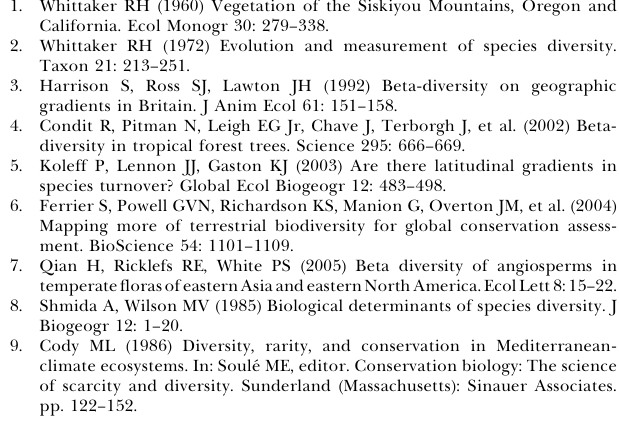
Figure S1. Scatter Plots Showing Relationships between Beta- Diversity and Two Environmental Variables (Elevation and Number of Biome Edges within Grid Cells) For each panel, untransformed (left plots) and transformed (right plots) values of b sim-d ( y -axis) against either grid cell elevation ( x -axis, upper plots) or number of biome edges within grid cell ( x -axis, lower plots). In each plot, the red dots represent the highest 2.5% of b sim-d grid cells, and the purple dots show the lowest 2.5% of b sim-d grid cells. (A) Amphibians. (B) Birds. (C) Mammals. Found at doi:10.1371/journal.pbio.0050272.sg001 (472 KB PDF).